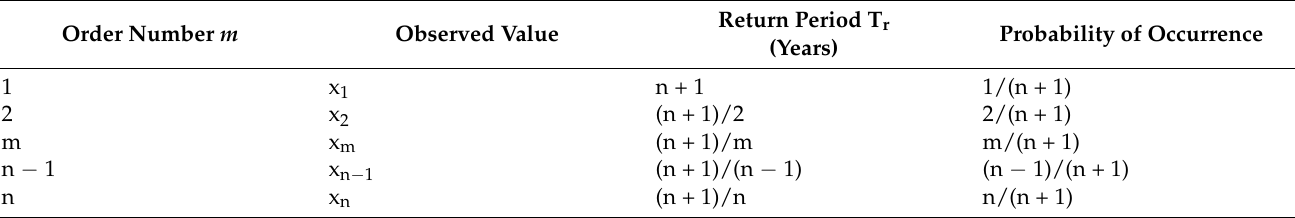
Table 3. Definition of the empirical return period and probability of occurrence